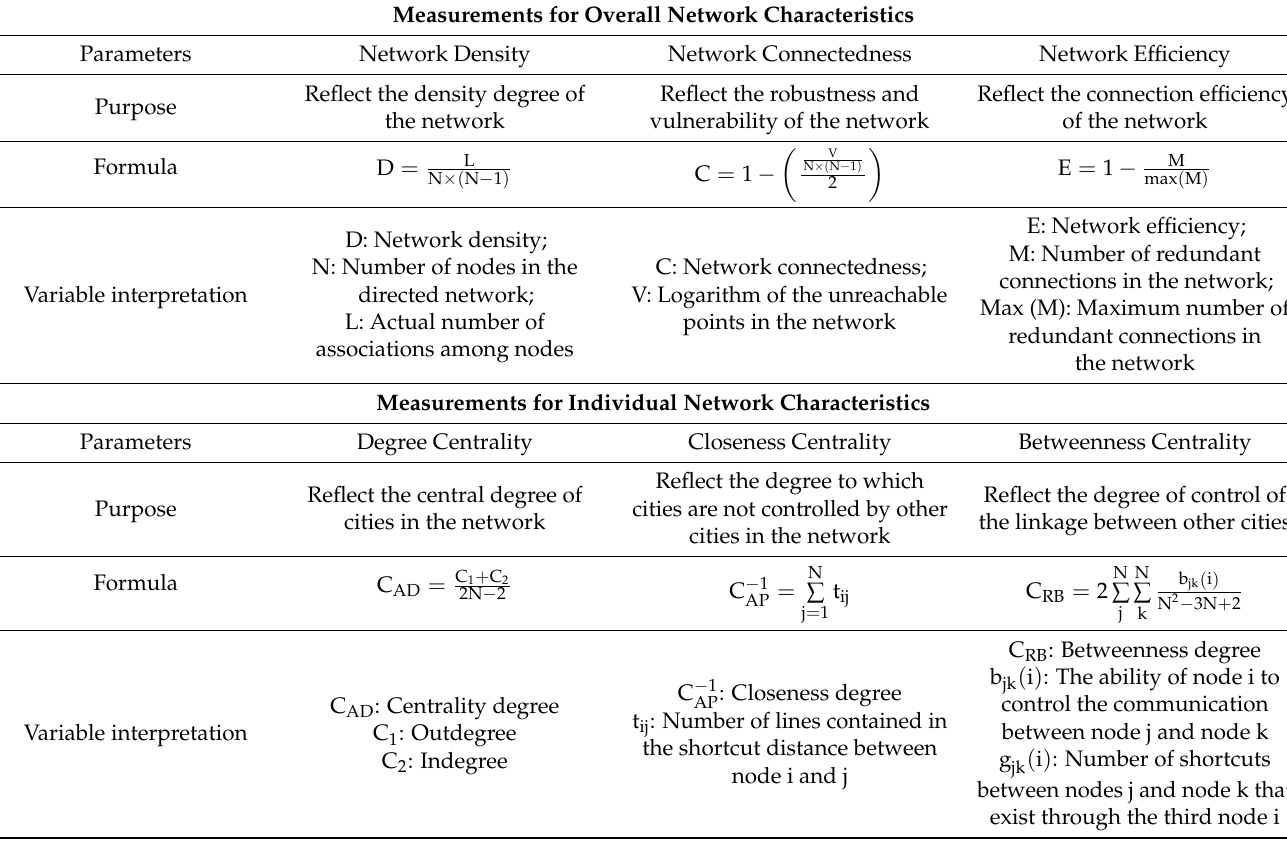
Table 2. Measurements of network